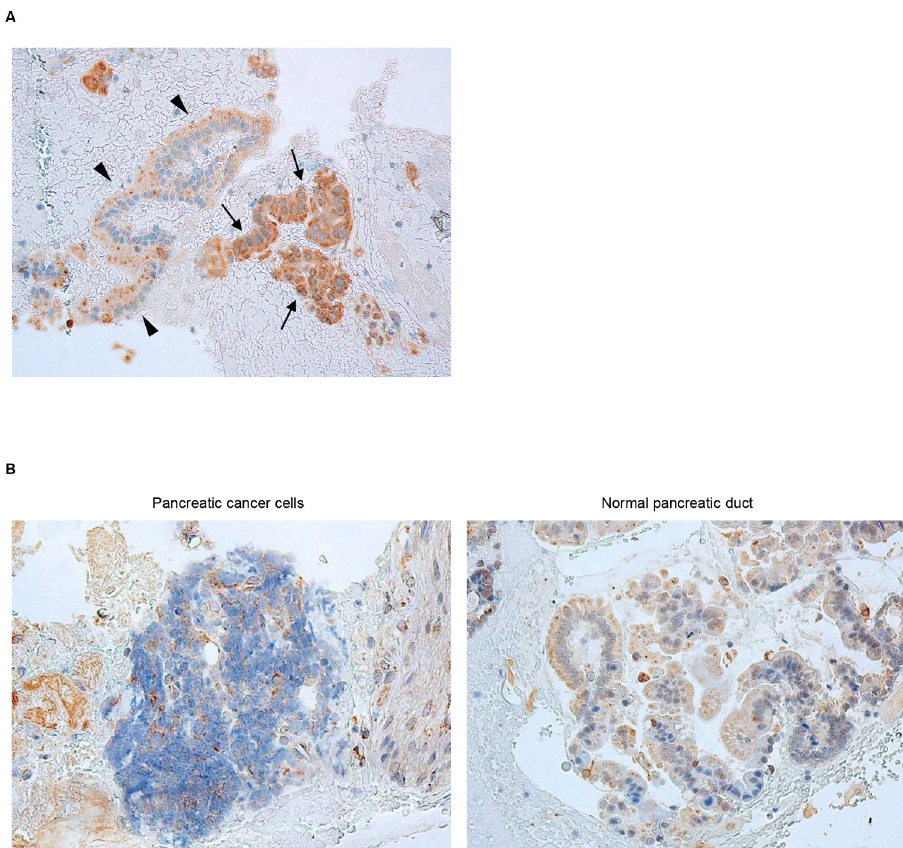
Fig 2. Expression of ITGB1 in PDAC tissues obtained by EUS-FNAB. (A, B) Representative immunohistochemical staining of PDAC tissue samples using anti-ITGB1 antibody showing (A) high and (B) low expression of ITGB1. Arrows, PDAC cells; arrowheads, normal pancreatic duct epithelium. Magnification: × 400.